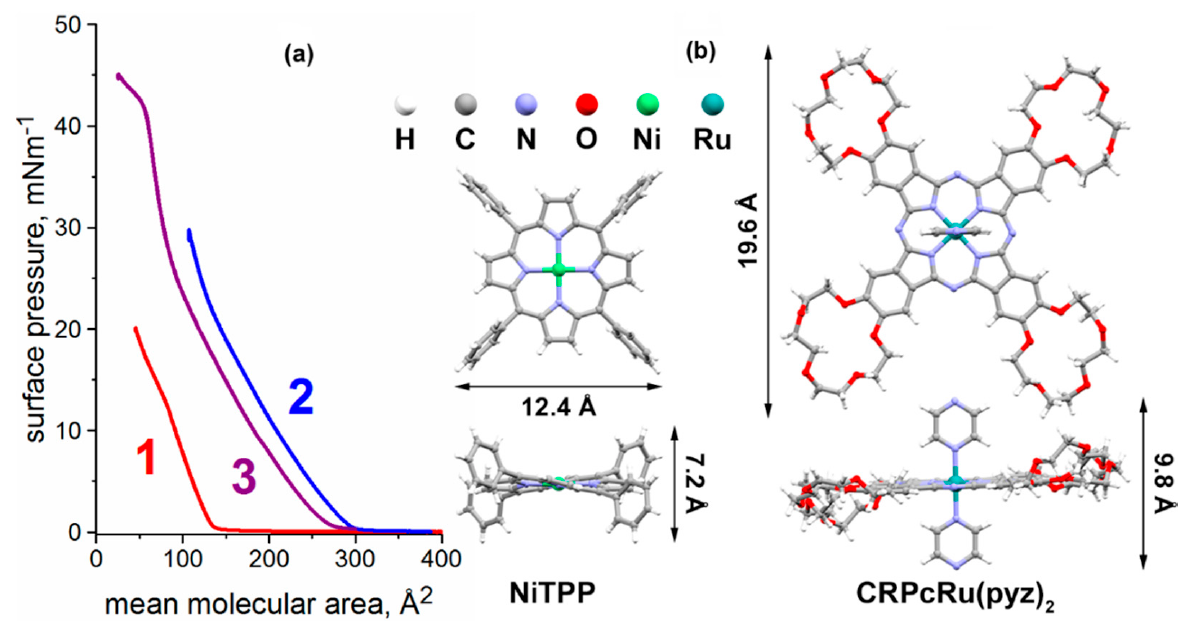
Figure 5. ( a ) Langmuir monolayer compression isotherms for (1) NiTPP , (2) CRPcRu(pyz) 2 , and (3) a mixed monolayer comprised of both in 1:1 molar ratio. ( b ) Chemical structures of the NiTPP and CRPcRu(pyz) 2 molecules obtained from X-ray crystallographic data [CCDC deposition numbers 904978 and 1056316 respectively] and corresponding estimated geometrical dimensions.